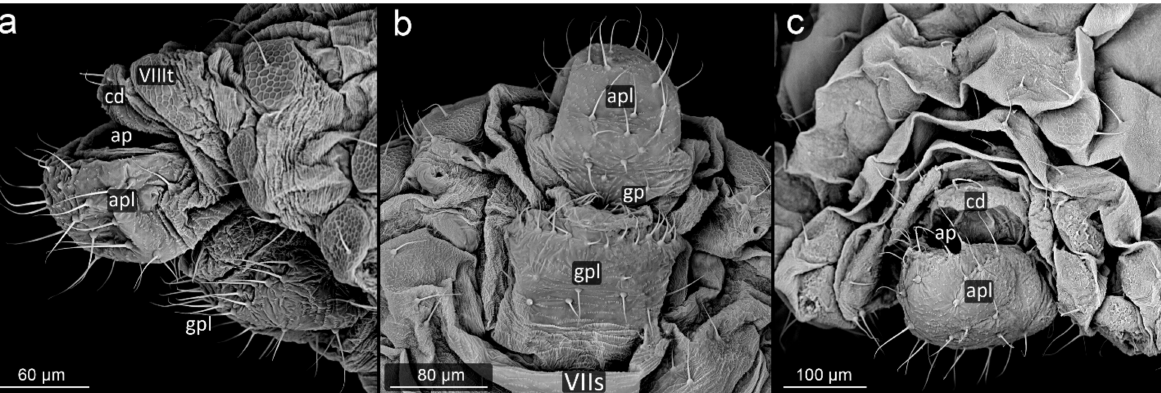
Figure 5. Perianal structure of Prociphilus fraxini in SEM; ( a )—lateral view, ( b )—abdominal view, ( c )—rear view.